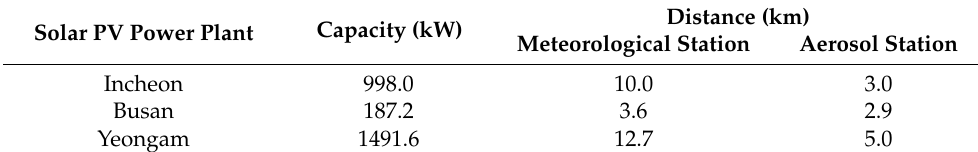
Table 2. The capacity of each solar PV power plant and distance for each station. Solar PV Power